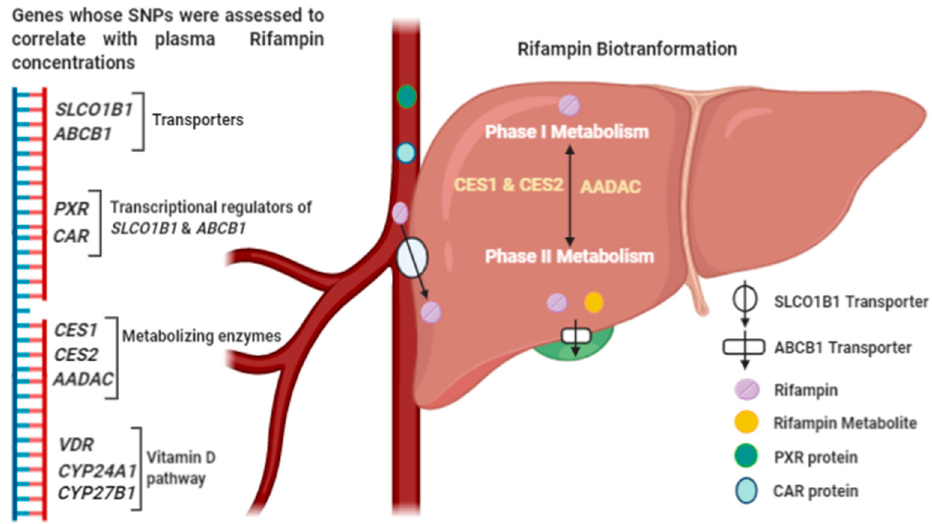
Figure 1. Schematic diagram representing. (1) The genes whose SNPs were assessed with plasma RF concentrations in the review and (2) RF biotransformation.